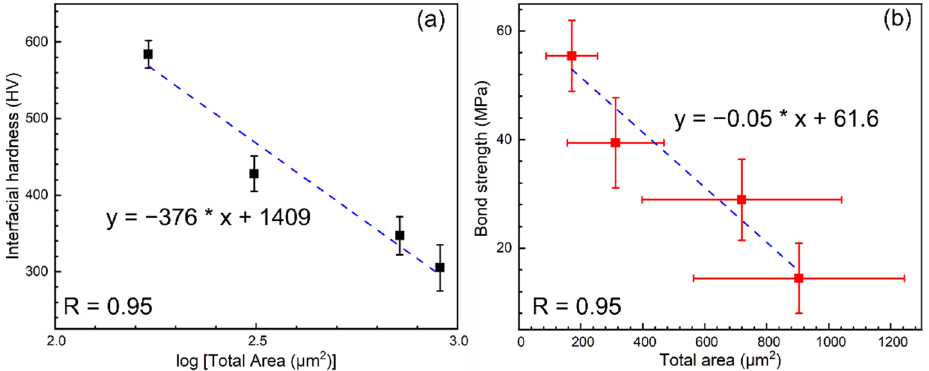
Figure 8. Relationship between the total areas of the coating samples and their mechanical proper- ties: ( a ) interfacial hardness and ( b ) bond strength. ( a ) interfacial hardness and ( b ) bond